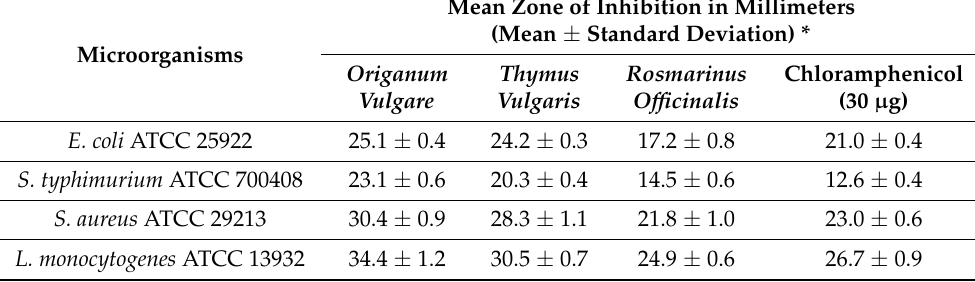
Table 6. Antibacterial activity of the essential oils of Origanum vulgare, Thymus vulgaris , and Rosmari- nus officinalis compared to chloramphenicol (30 µ g/disc). Mean Zone of Inhibition in Millimeters (Mean ± Standard Deviation) * Microorganisms